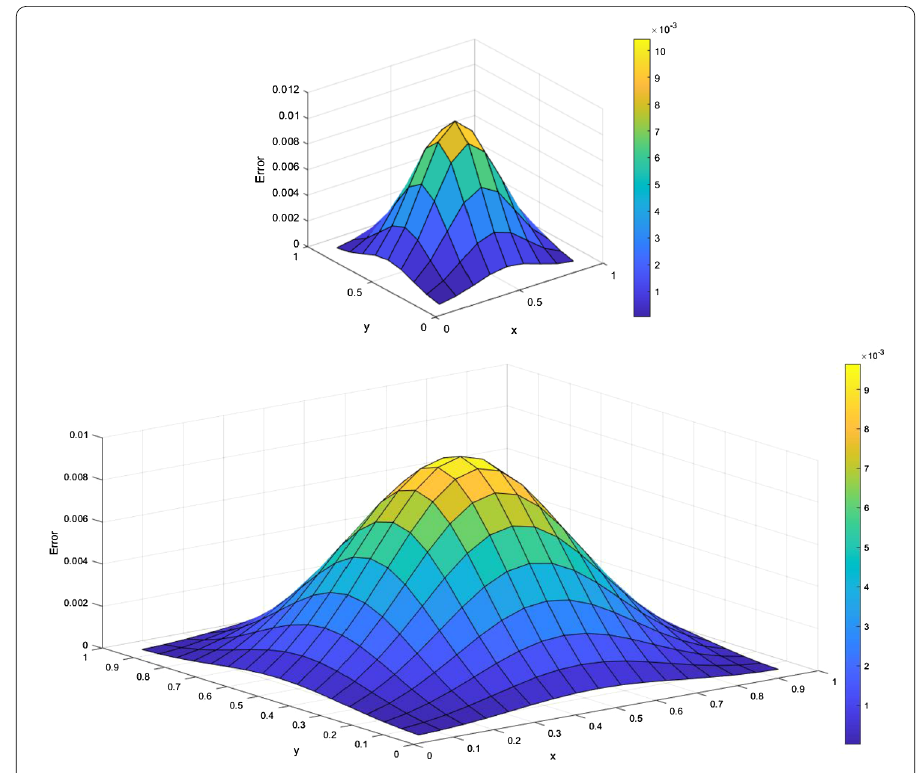
Table 16 The total computation effort for different mesh size for Example 1 when α = 0.75 k / m High-order finite difference method HEGM No. of iter. Total operations No. of iter. Total operations k = m = 10